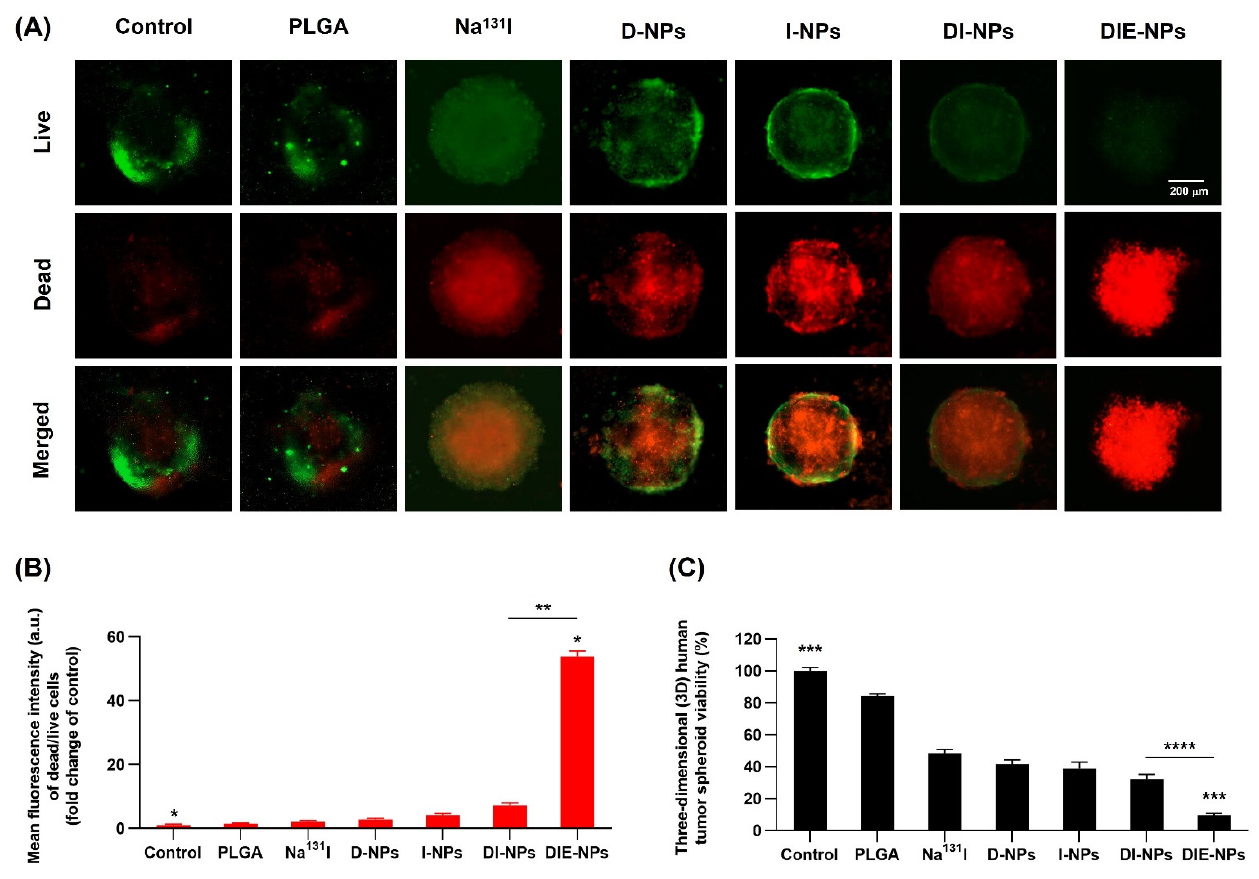
Figure 9. In vitro live/dead cell imaging of three-dimensional (3D) human tumor spheroids. ( A ) In vitro live/dead imaging of MG-63 cell tumor spheroid treated with control, PLGA, Na 131 I, D-NPs, I-NPs, DI-NPs and DIE-NPs. MG-63 cells were treated with a fixed concentration of I-131 activity 3.70 MBq for 72 h. Two-color fluorescence live (green channel) and dead (red channel) enabled the evaluation of live and dead cells to determine cell viability and cytotoxicity. Additionally, to eliminate out-of-focus fluorescent signals, all the channels were deconvolved by software [10 × images, scale bar = 200 µm]. ( B ) Mean fluorescence intensity of dead/live (fold change of control) of MG-63 cell tumor spheroid treated with control, PLGA, Na 131 I, D-NPs, I-NPs, DI-NPs and DIE-NPs. MG-63 cells were treated with a fixed concentration of I-131 activity 3.70 MBq for 72 h. * denotes significance in mean fluorescence intensity of dead/live (fold change of control) of MG-63 cell tumor spheroid treatment between control and DIE-NPs ( p < 0.05). ** denotes significance in mean fluorescence intensity of dead/live (fold change of control) of MG-63 cell tumor spheroid treatment between DI-NPs and DIE-NPs ( p < 0.05). ( C ) Three-dimensional (3D) human tumor spheroid viability using Cell Titer-Glo ® 3D cell assay of MG-63 cell tumor spheroid treated with control, PLGA, Na 131 I, D-NPs, I-NPs, DI-NPs and DIE-NPs. MG-63 cells were treated with a fixed concentration of I-131 activity 3.70 MBq for 72 h. *** denotes significance in viability of MG-63 cell tumor spheroid treatment between control and DIE-NPs ( p < 0.05). **** denotes significance in viability of MG-63 cell tumor spheroid treatment between DI-NPs and DIE-NPs ( p < 0.05). Data are given as mean ± standard deviation ( n =